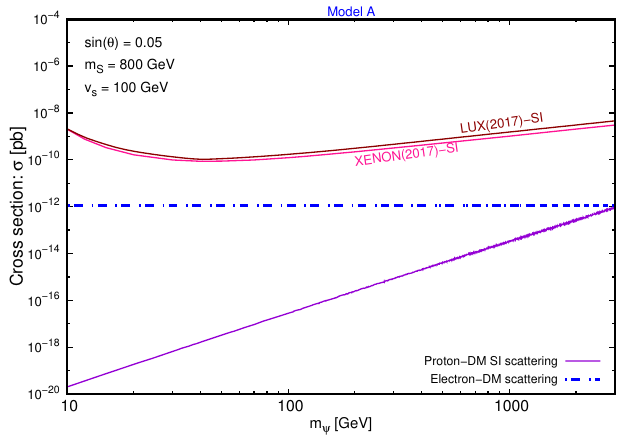
Figure 6 . Same scan for model A as that in (cid:12)gure 5, except that the ( g (cid:0) 2) (cid:22) constraint on the model A is